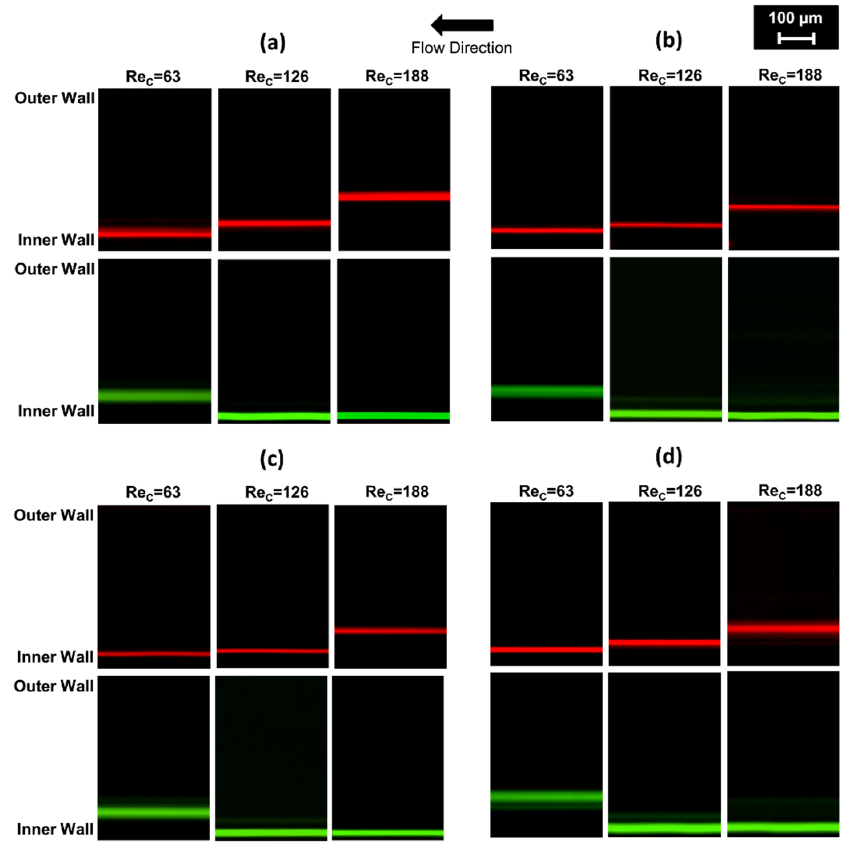
Figure 6. The trajectories of the particle streamlines at the end of the last spiral loop, where the channel width is 500 µm for 10 µm (red lines) and 20 µm (green lines) at Re c values of 63, 126, and 188 for ( a ) Case 1, ( b ) Case 2, ( c ) Case 3, and ( d ) Case 4.